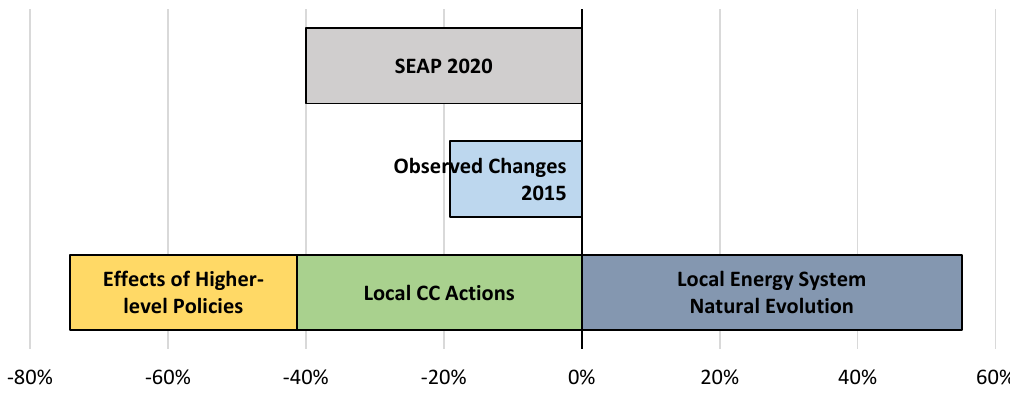
Figure 6. Change in GHG emissions for the municipality of Malmö (ktCO 2 eq. /year) due to local actions and to external factors and the overall change as estimated by the disaggregation model (1990–2015) and as projected by the SEAP (1990–2020).